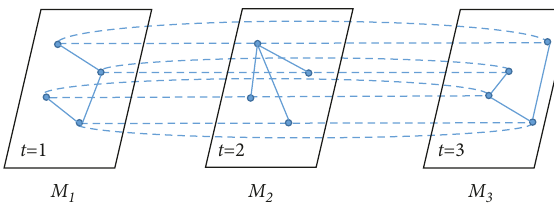
Figure 1: The innovation value transformation